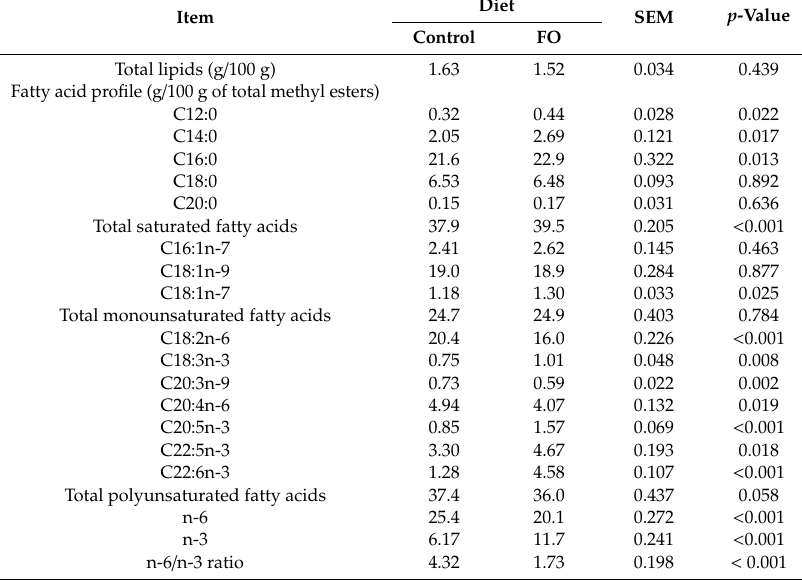
Table 4. Total lipid content and fatty acid profiles in the Longissimus lumborum muscle of growing rabbits fed diets with either lard (control) or fish oil (FO) as the fat source and slaughtered at 60 days of age 1